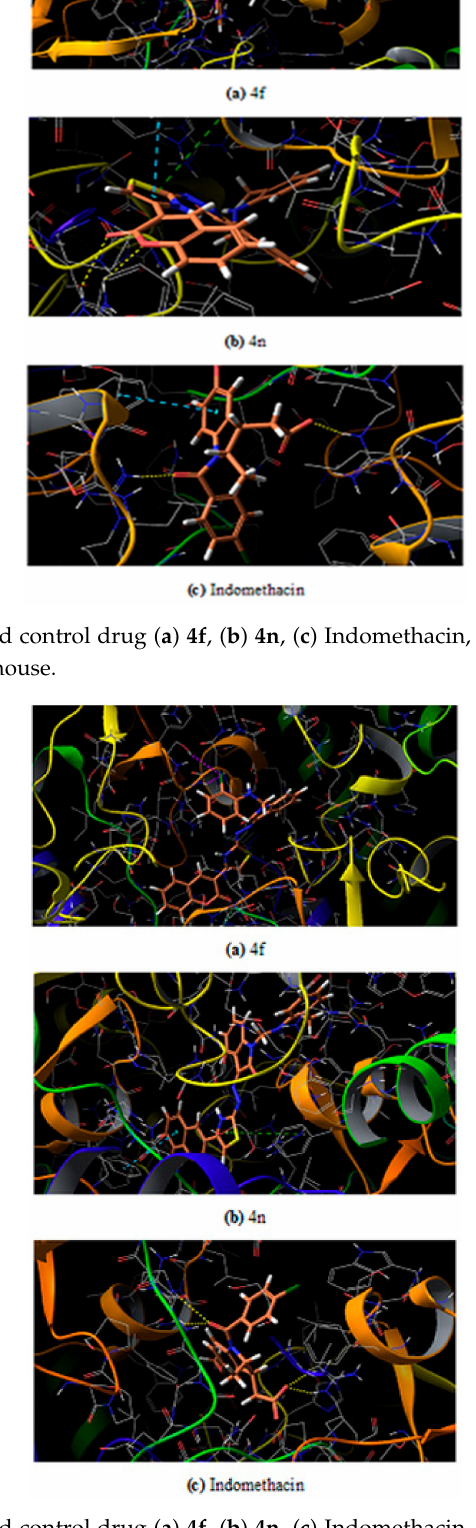
Figure 6. Test ligands and control drug ( a ) 4f , ( b ) 4n , ( c ) Indomethacin, docked inside the binding pocket of COX-2 from the